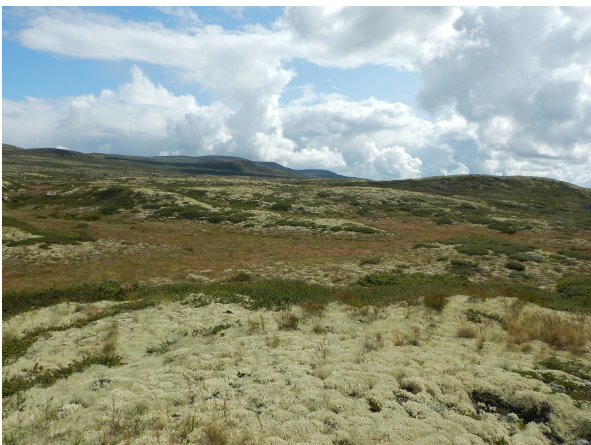
Figure A1. Picture of the study area. Lichen heaths are mainly located on the windswept ridgetops, while shrubs are located on the midslopes and ridgetops.